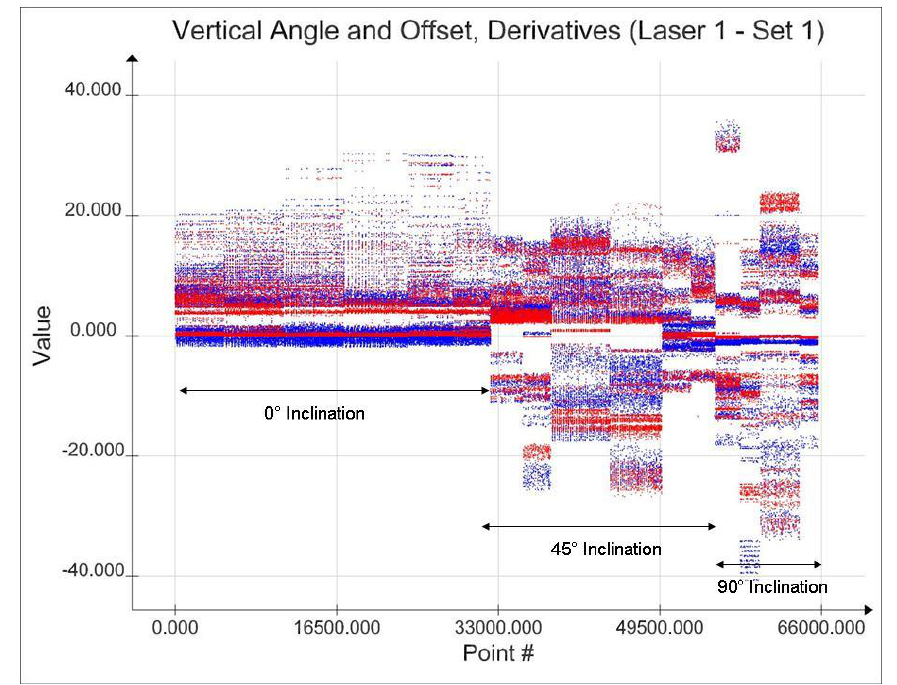
Figure 3. Comparison of First Derivatives For Vertical Offset (Red) and Vertical Angle (Blue) Unknowns, Laser 1–Set 1.